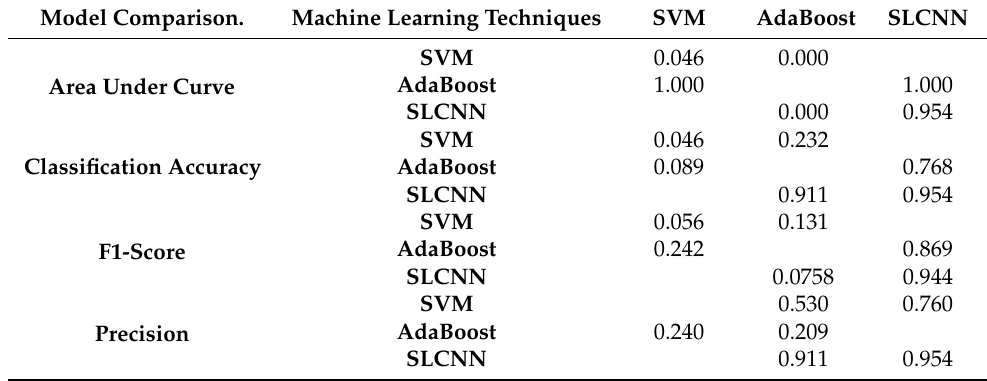
Table 9. Models’ comparison by performance measurements. Model